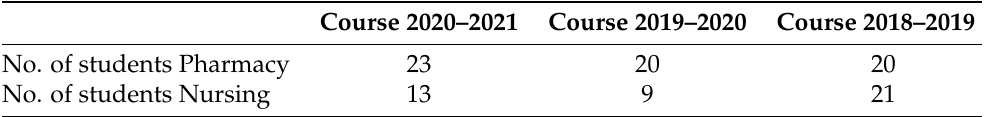
Table 1. No. of students according to the degree.